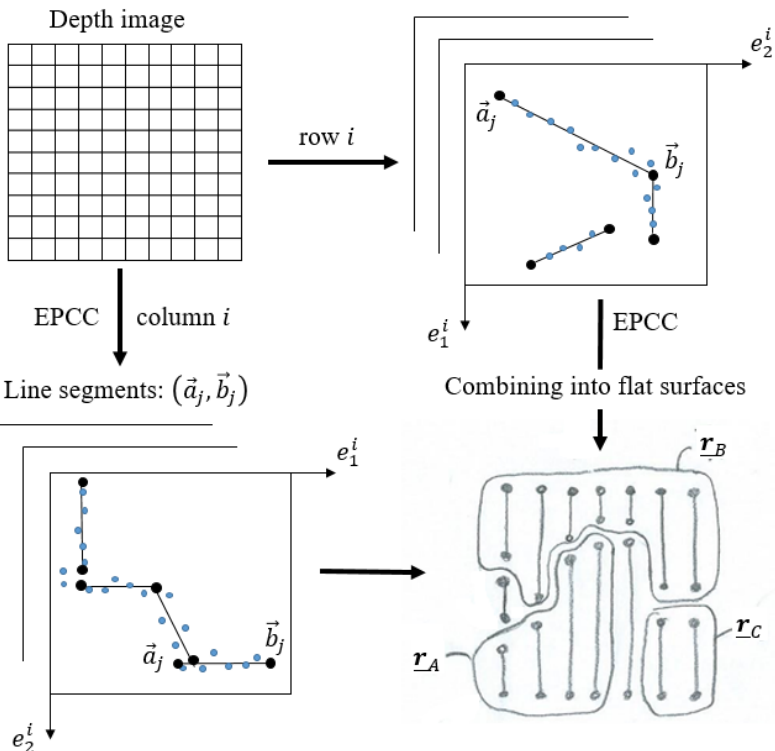
Figure 3. The concept of planar depth image segmentation with the EPCC method, in which the detection of 3D line segments takes place in 2D projections of columns or rows of the data matrix. Variables e i and e i represent the 2D coordinates of the points in the i -th column. With the process 2 1 of line segment aggregation, we achieve a 3D-planar representation of the environment, where { r } represent flat surfaces or bounded planes determined by the start and end points { a A , r B , r C of line